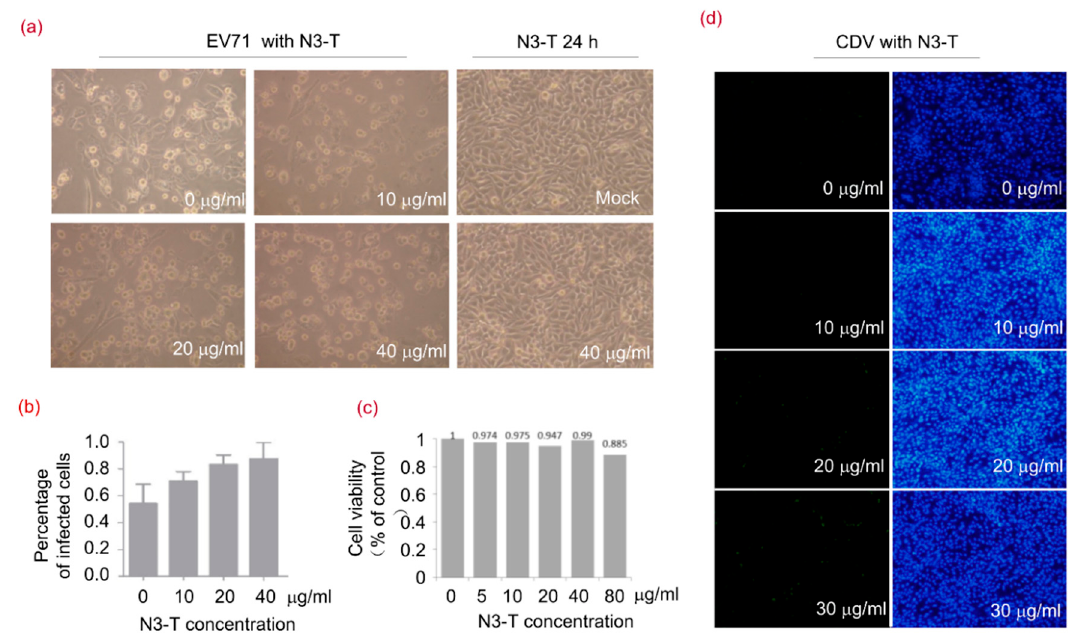
Figure 6. N3-T Promotes Viral Replication in a Dose-Dependent Manner. ( a , b ) RD cells were mock-infected or exposed to EV71 of 1 TCID 50 for 24 h in the presence of PBS or N3-T at the indicated concentrations. The cells were imaged by light microscopy using an Olympus microscope (magnificence 100 × ) ( a ); and infected cells were quantified from three randomly selected images ( b ); Shown are the means with SD, ( c ) Cells were treated with various concentrations of N3-T for 24 h, and cell viability was determined by the lactate dehydrogenase (LDH) assay; ( d ) Vero cells were exposed to CDV of 0.01 MOI for 36 h in the presence of PBS or N3-T at 0, 10, 20, or 30 µ g/mL. The infected cells were imaged by fluorescence microscopy using an Olympus IX73 microscope (magnification of 100 × ) equipped with a DP73 camera (left) and assessed under light microscopy (panels c , d ). Each image is representative of three experiments (right).